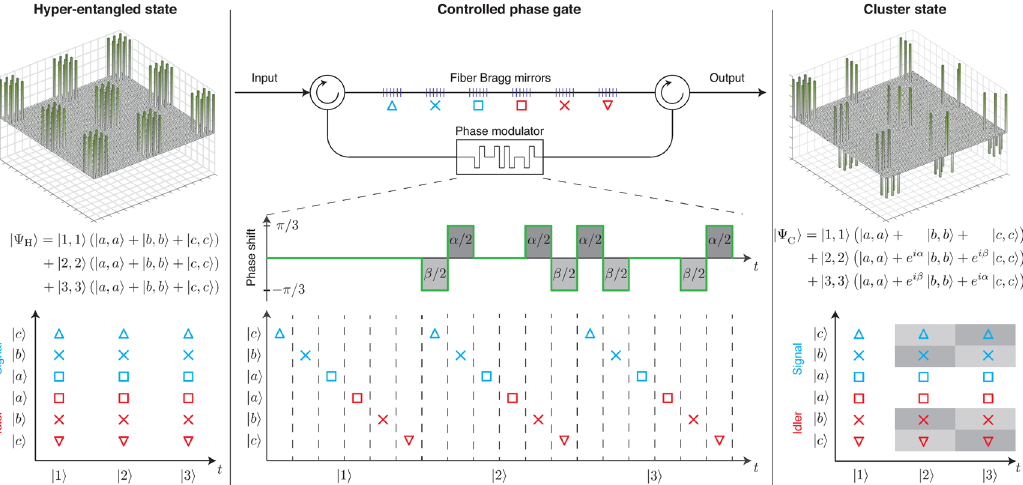
Figure4: Clusterstategenerationthroughthecontrolled-phasegate.Leftpanel:aseparablehyper-entangledstateisusedastheinputtothe C-phase gate. Central panel: controlled phase gate, consisting of the two circulators, the fiber Bragg mirrors for frequency-to-time mapping, andthephasemodulatorforaddingthespecificphasetermsinsuchawayto transformtheseparablestateintothetarget clusterstate.Right panel: four-partite three-level cluster state obtained as C-phase gate output. The two density matrices have been constructed analytically. Adapted from